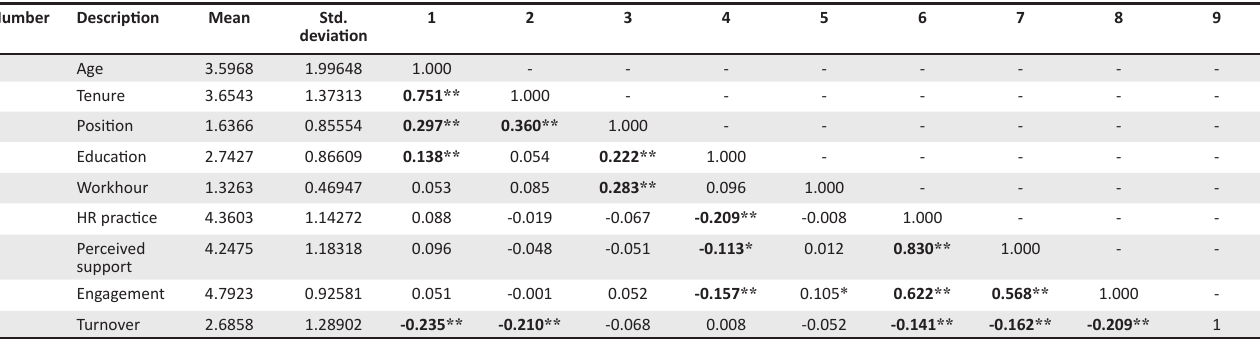
TABLE 7: Mean, standard deviation, correlation.